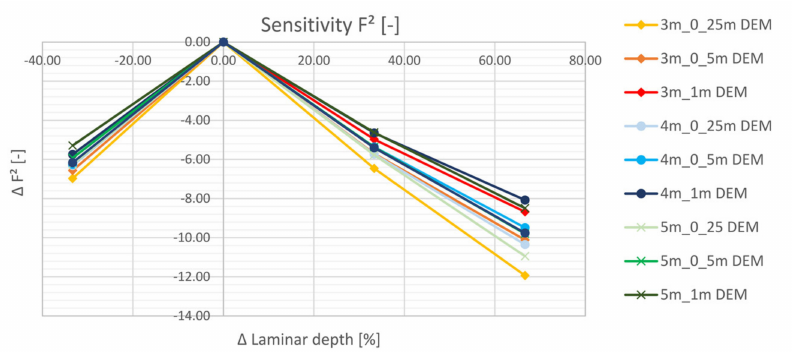
Figure 26. Comparison of the model sensitivity (S-F 2 ) for laminar depth and the evaluated mesh and DEM